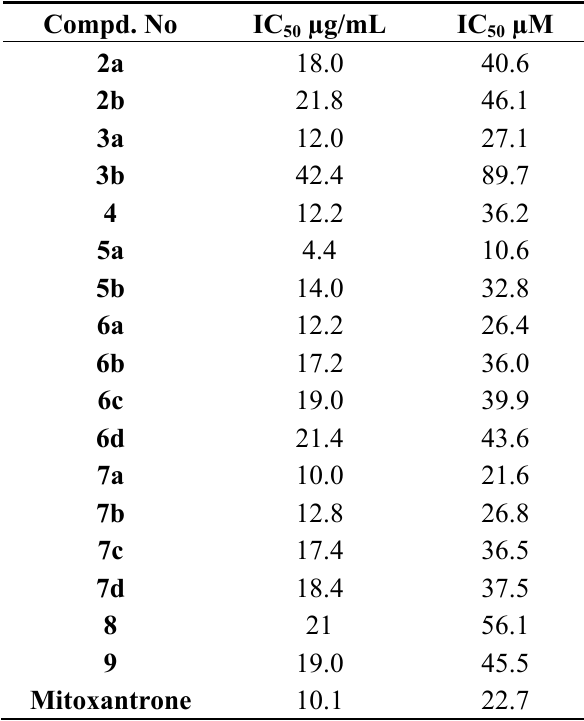
Table 1. Cytotoxic activity of the newly synthesized compounds against breast cancer MCF7 cell